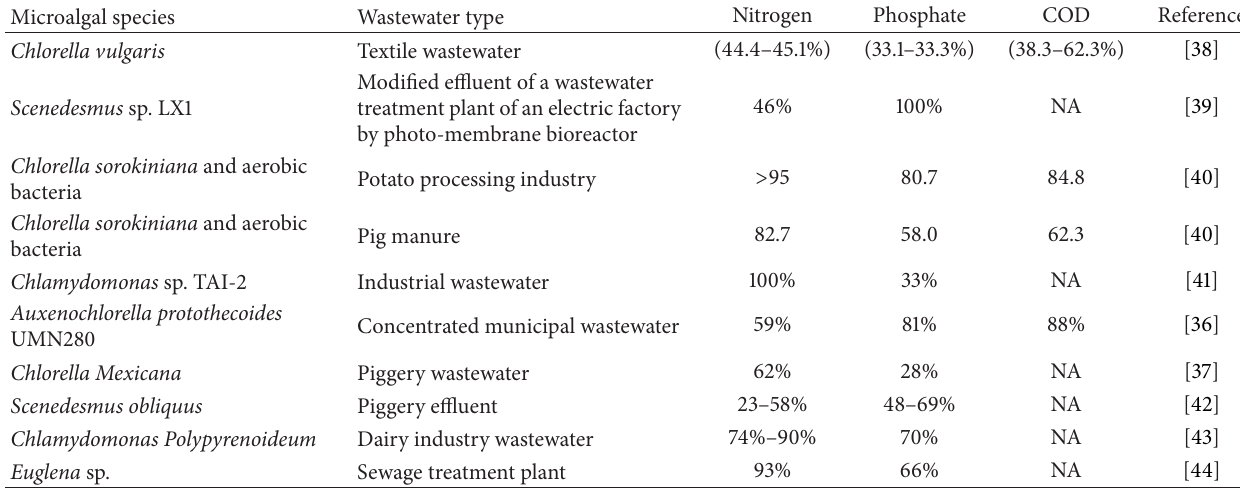
Table 2: Nutrient removal efficiency of microalgal